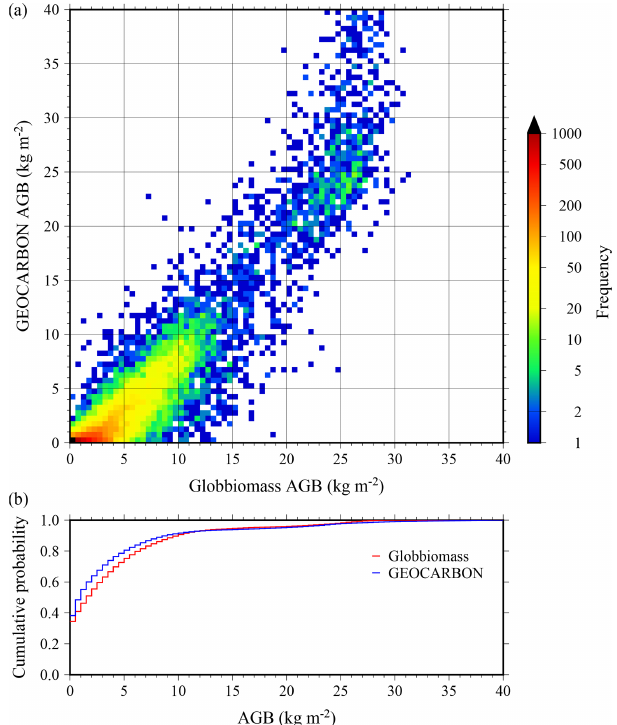
Figure 1. Comparisons of (a) AGB for 2009 based on Globbiomass and GEOCARBON and (b) their histograms.